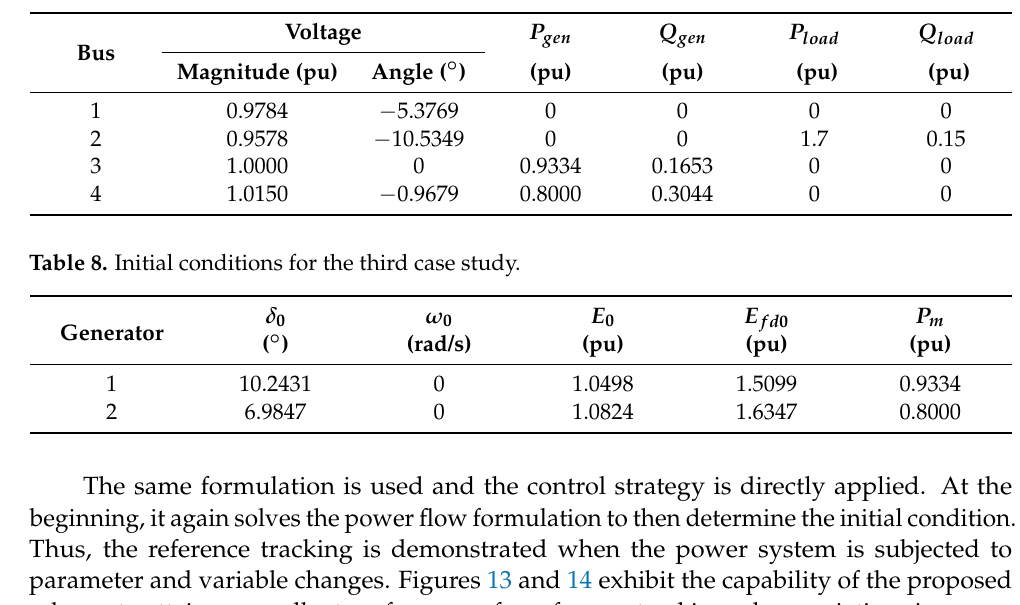
Table 7. Power flow solution.